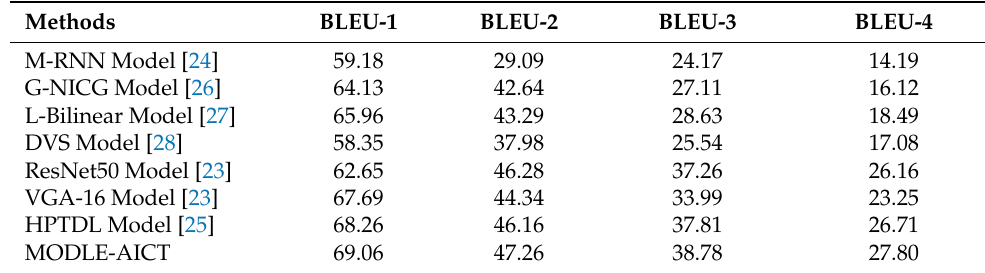
Table 2. Result analysis of MODLE-AICT algorithm with approaches on Flickr8K dataset.